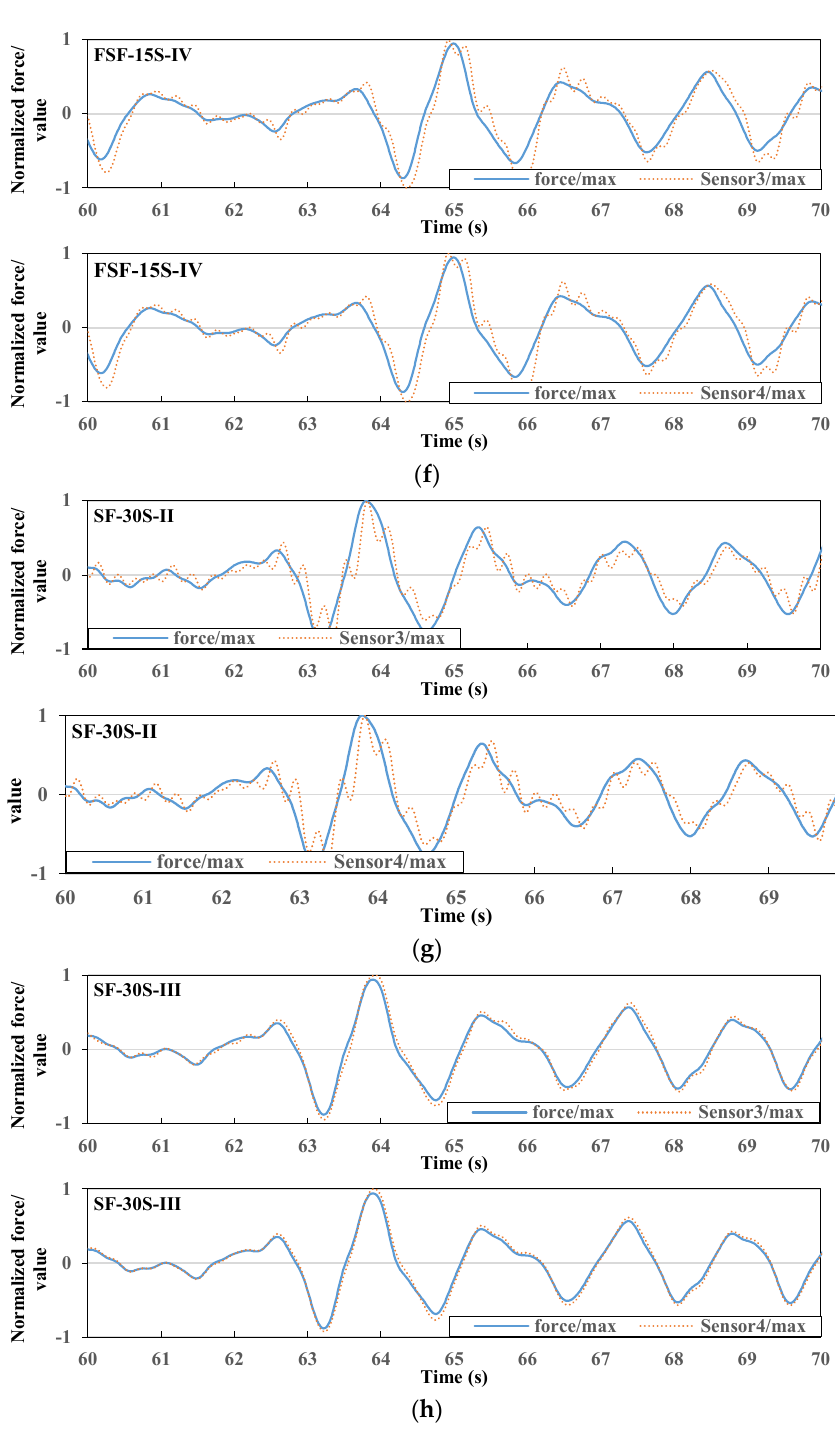
Figure 12. Window view (60–70 s) of waveforms of specimens from Figure 11. ( a ) FF-15S-II (Sensor 3 and Sensor 4); ( b ) FF-15S-III (Sensor 3 and Sensor 4); ( c ) FF-15S-IV (Sensor 3 and Sensor 4); ( d ) FSF-15S-II (Sensor 3 and Sensor 4); ( e ) FSF-15S-III (Sensor 3 and Sensor 4); ( f ) FSF-15S-IV (Sensor 3 and Sensor 4); ( g ) SF-30S-II (Sensor 3 and Sensor 4); ( h ) SF-30S-III (Sensor 3 and Sensor 4).